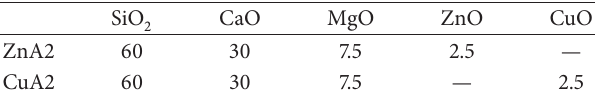
Table 1: Bioactive scaffold compositions in